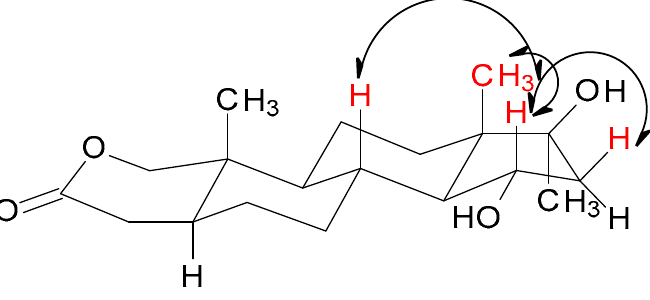
Figure 4. Key NOESY correlations for 15 α -hydroxyoxandrolone ( 5 ).